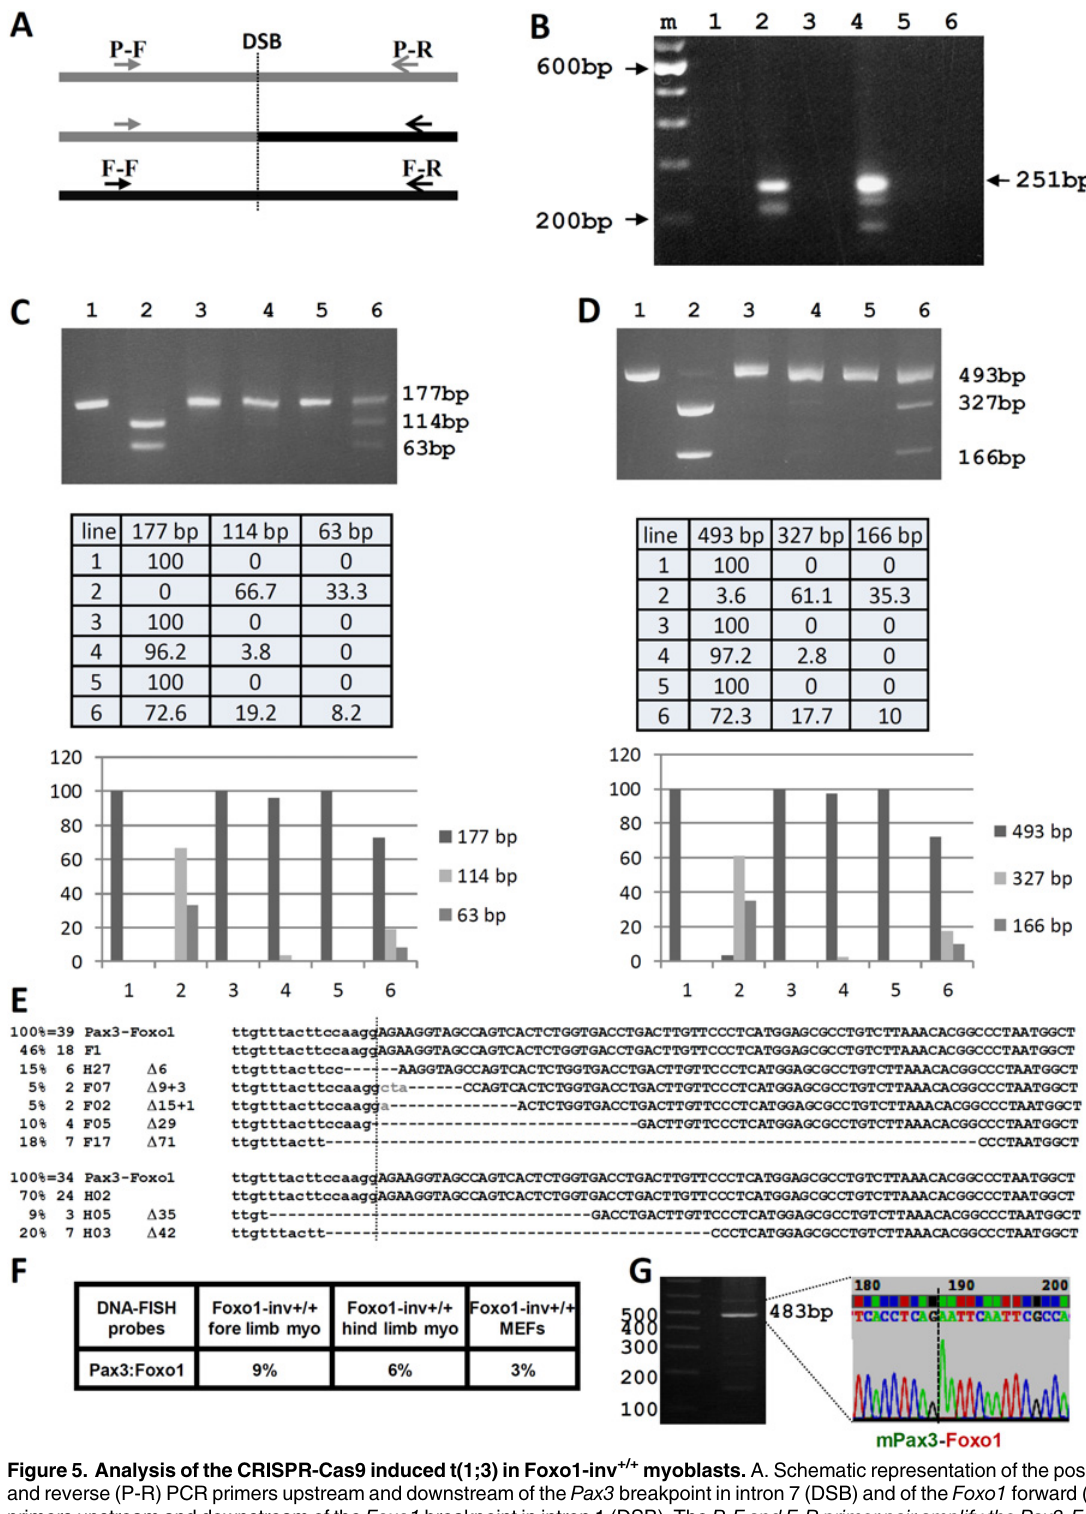
PLOS Genetics | DOI:10.1371/journal.pgen.1004951 February 6,